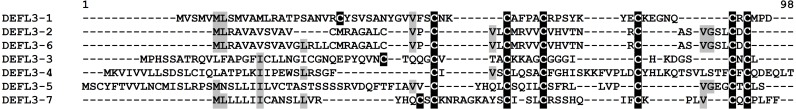
Multiple sequence alignment of T. kiharae group 3 DEFLs.Cysteine residues are shaded black, and identical amino acids are shaded gray.